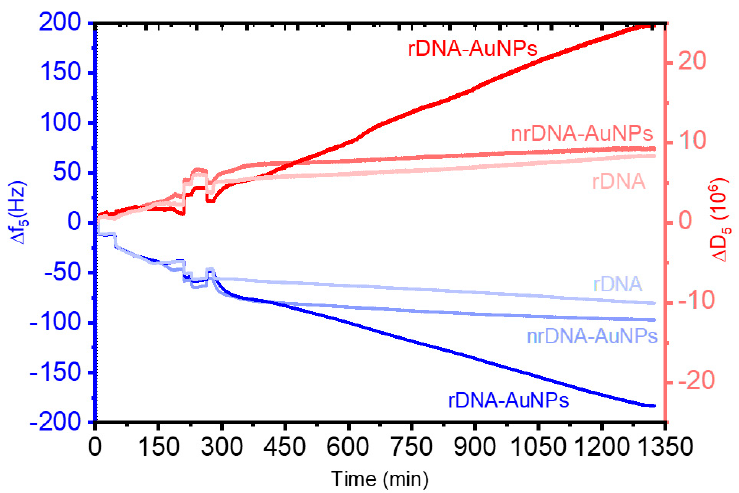
Figure 1. QCM-D sensograms of: the assembly of PLL-OEG 22 -Mal 4.6 (0.25 mg/mL in PBS, pH 7.4); thiol-probe DNA (HS-DNA, 1 μ M in PBS); target DNA (tDNA, 1 μ M in PBS) and reporter probe DNA (rDNA, 1 μ M in PBS), reporter DNA with AuNPs (rDNA-AuNPs, 0.66 nM in PBS), or non-reporter DNA (nrDNA-AuNPs, 0.7 nM in PBS) as a control experiment.